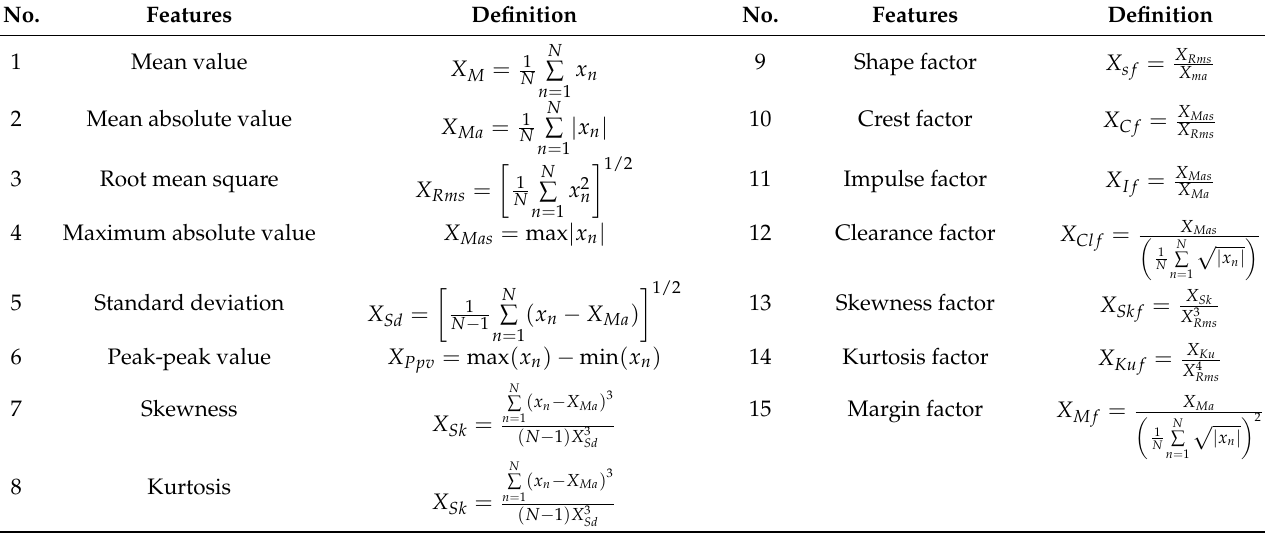
Table 2. The selected time-domain